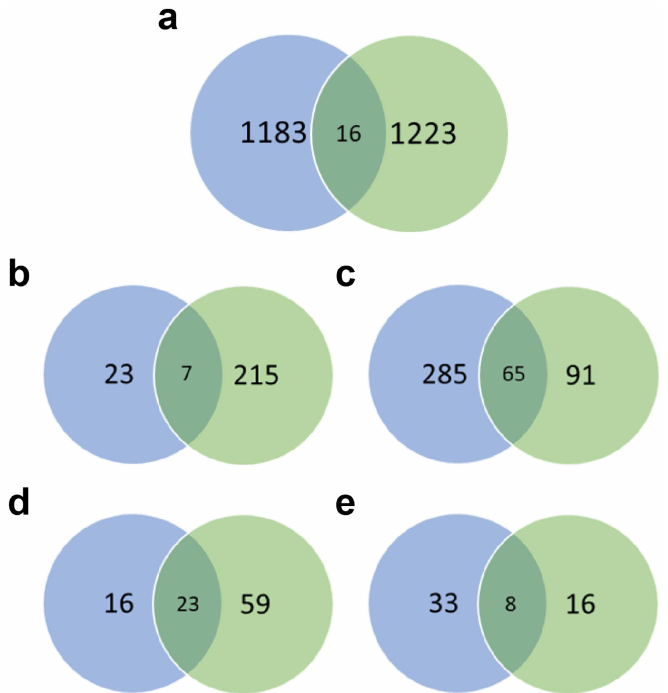
Figure 5. Overlap analysis of the transcriptomes of C6/36 and Aag2 cells. Blue represents the transcriptome analysis results of Aag2 cells, and green represents the transcriptome analysis results of C6/36 cells. ( a ) The 16 overlapping DEGs between the Aag2 and C6/36 cell lines. ( b ) The 7 overlapping GO terms enriched for upregulated DEGs. ( c ) The 65 overlapping GO terms for downregulated DEGs. ( d ) The 23 overlapping KEGG pathways enriched for upregulated DEGs. ( e ) The 8 overlapping KEGG pathways for downregulated